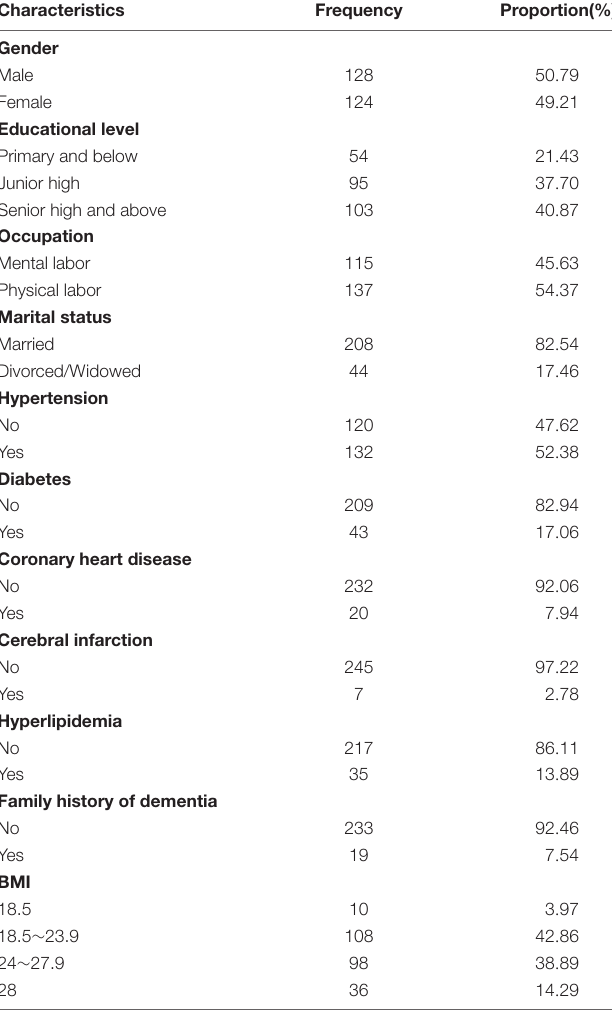
TABLE 1 | Characteristics of participants ( n = 252).